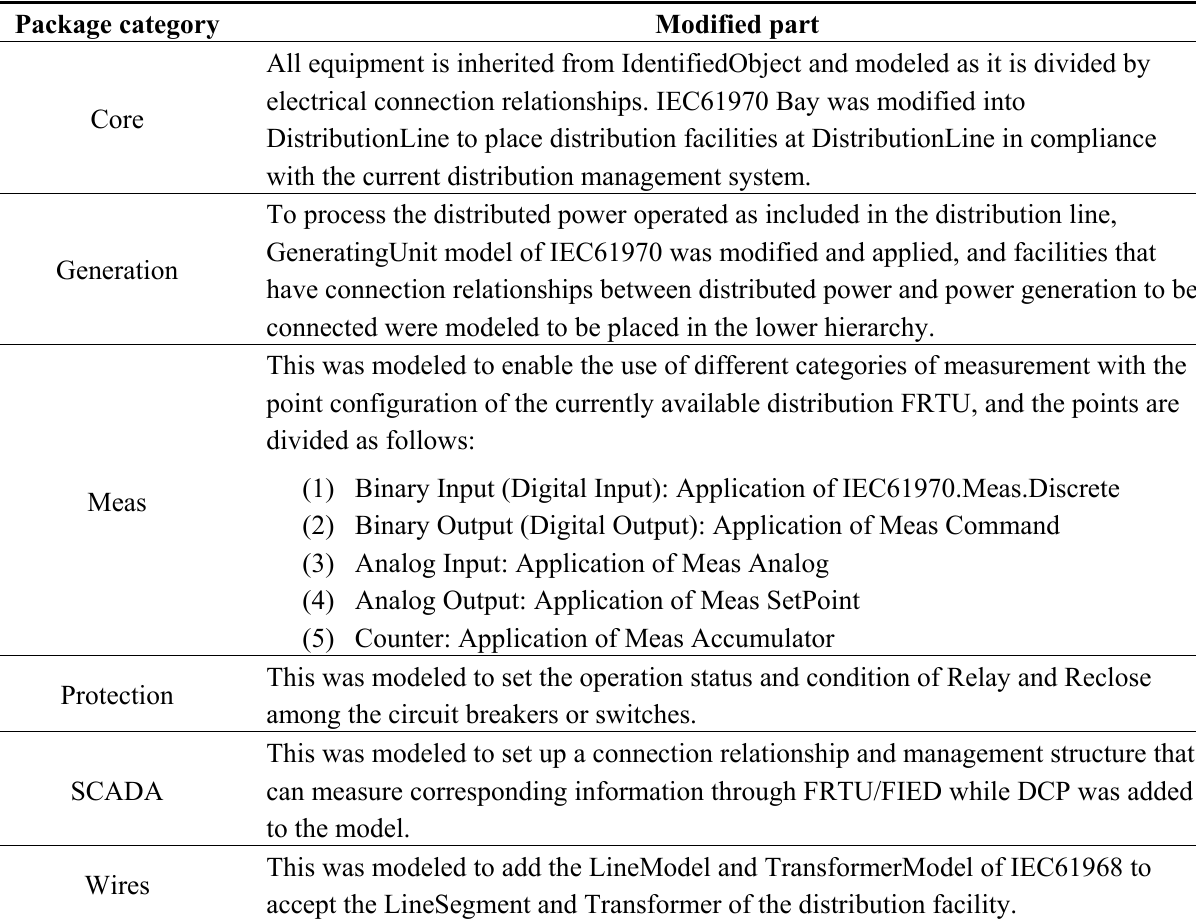
Table 2. Modeling method of converted CIM DB